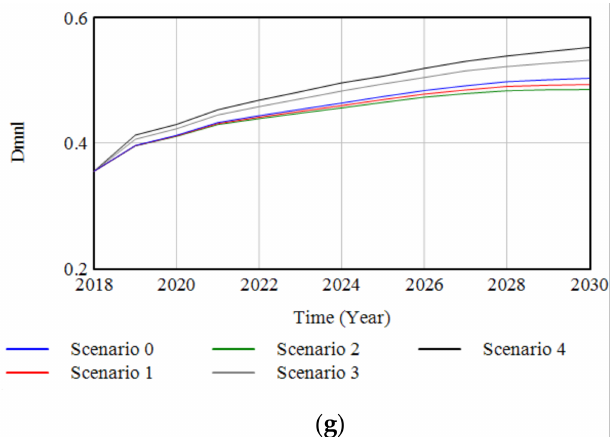
Figure 7. Variation of indicators in a single scenario. ( a ) Annual profits; ( b ) annual costs; ( c ) emission reduction per ton of clinker; ( d ) annual CO 2 emissions; ( e ) annual carbon trading costs; ( f ) innovation investment; ( g ) competitiveness index of the cement